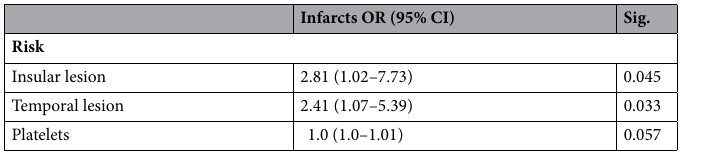
IOM (n = 134) No infarct (n = 118) Infarct (n = 16)